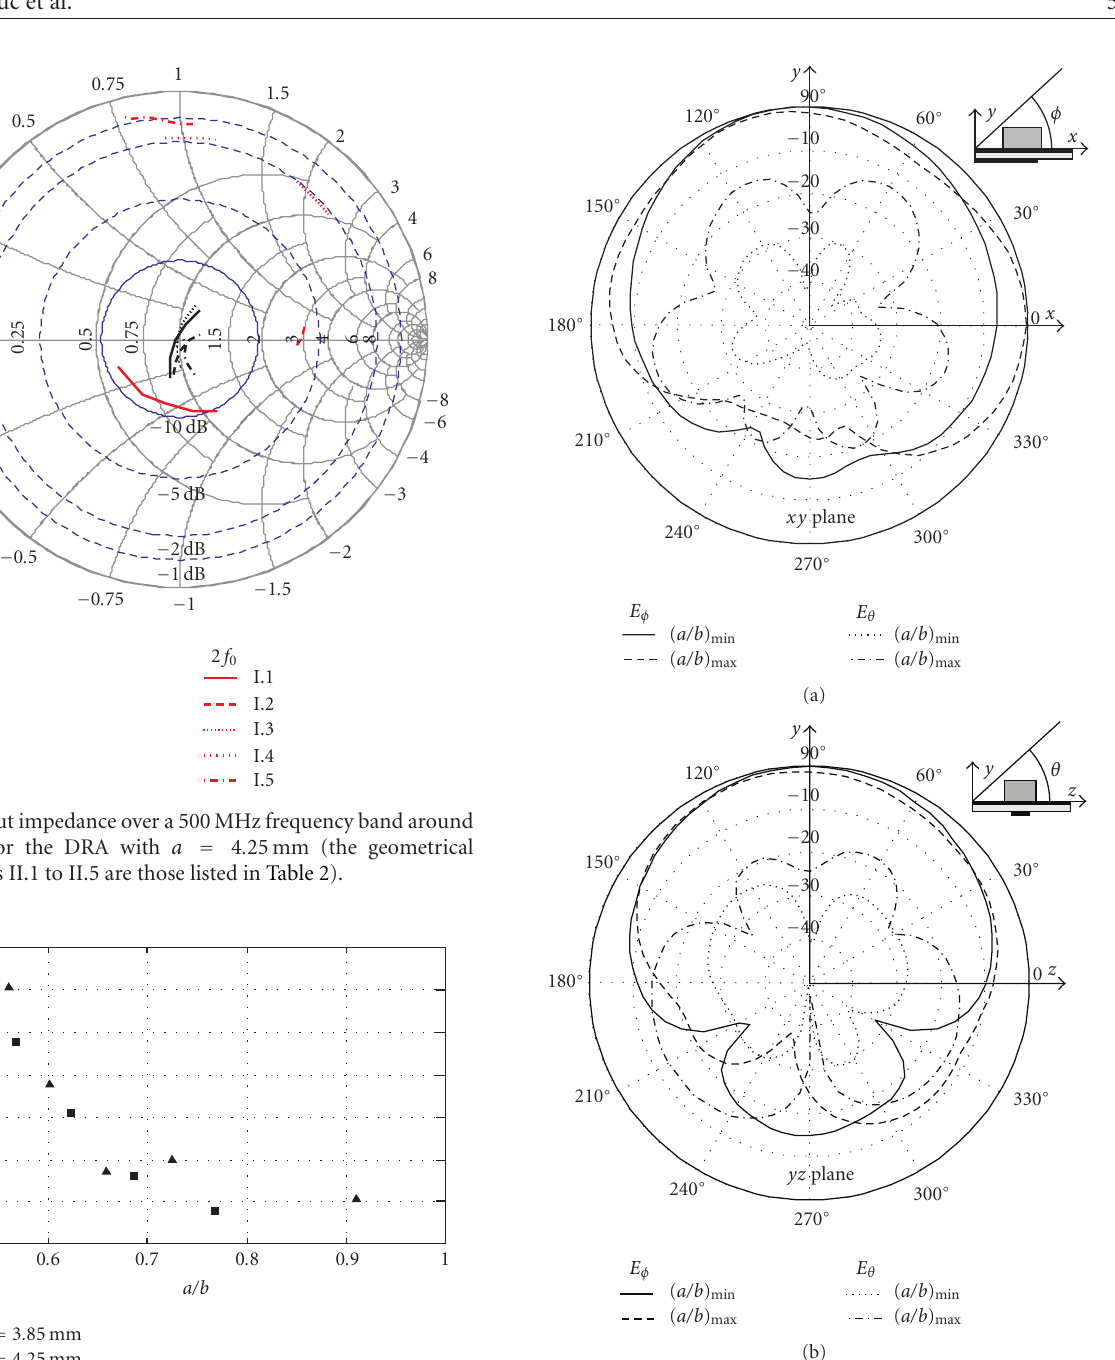
Figure 7: Percentage bandwidth (VSWR < − 10dB) versus the length-to-height ratio (the other geometrical parameters are those shown in Figure 2).